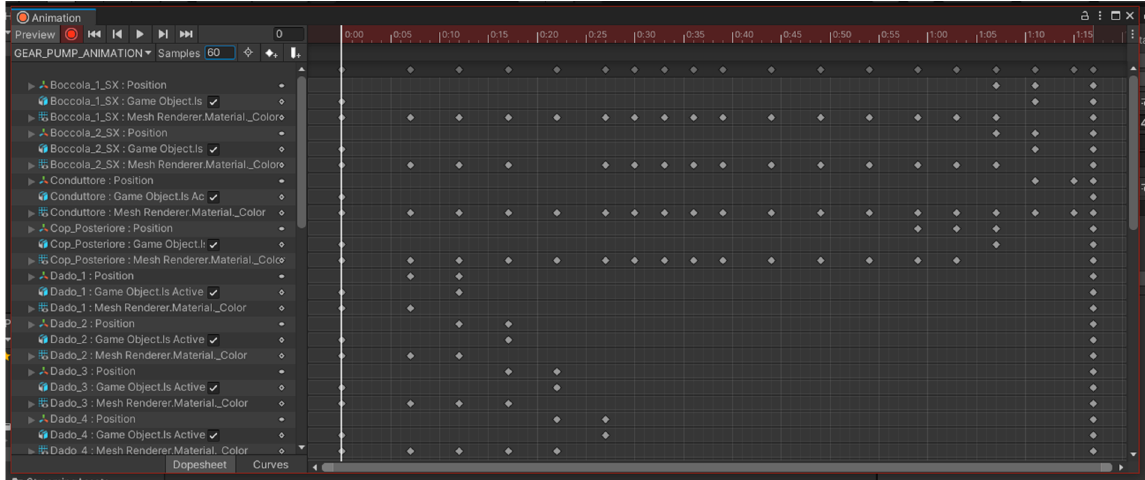
Figure 16. Animation sheet of the third disassembly sequence.